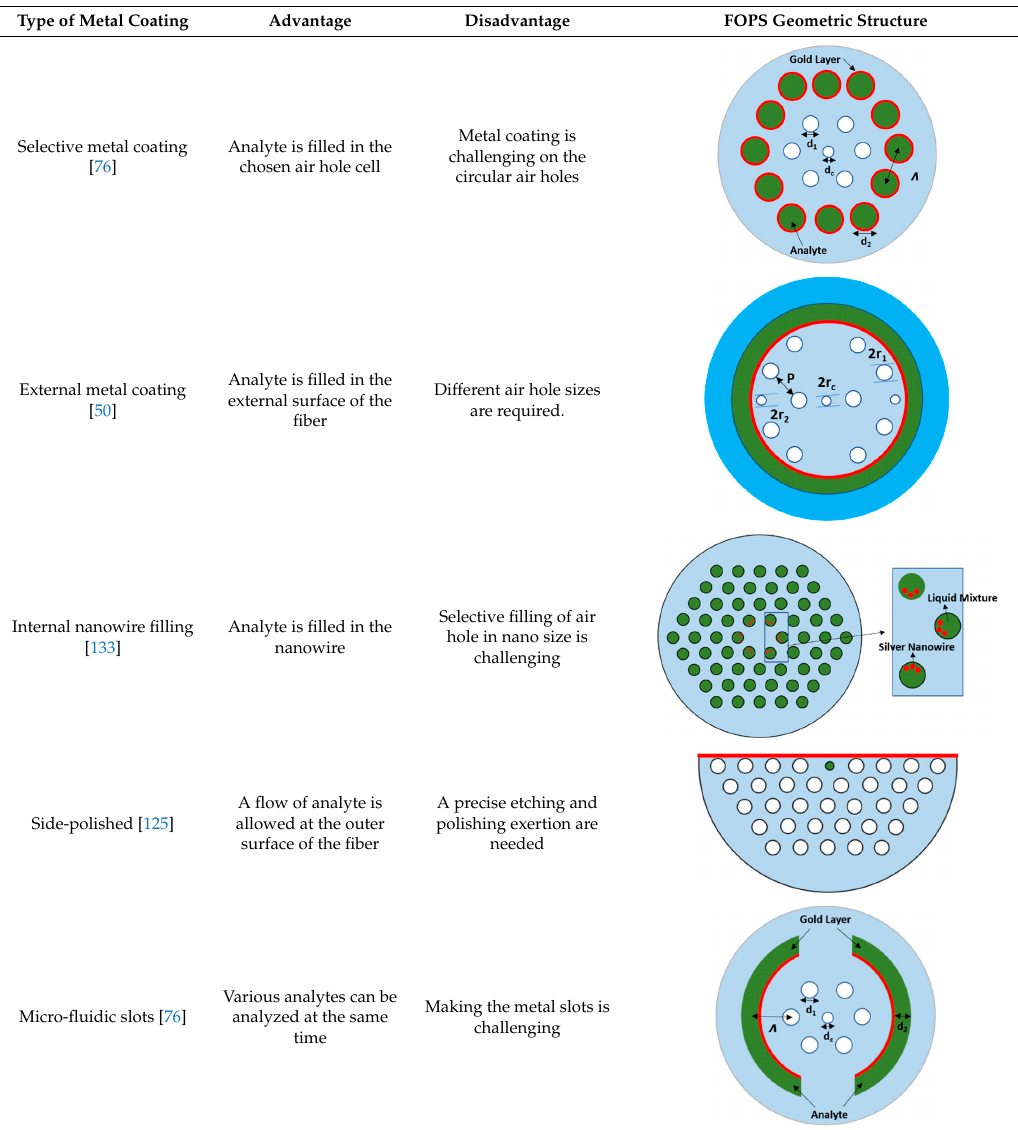
Table 2. Various metal-coating techniques in the different geometry of FPOS (Fiber Optic Plasmonic Sensor).